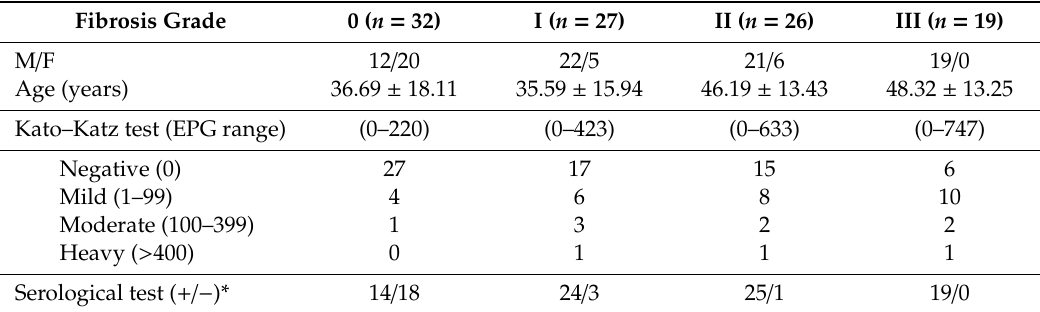
Table 4. The infection status and intensity of the cohort stratified by fibrosis grade.